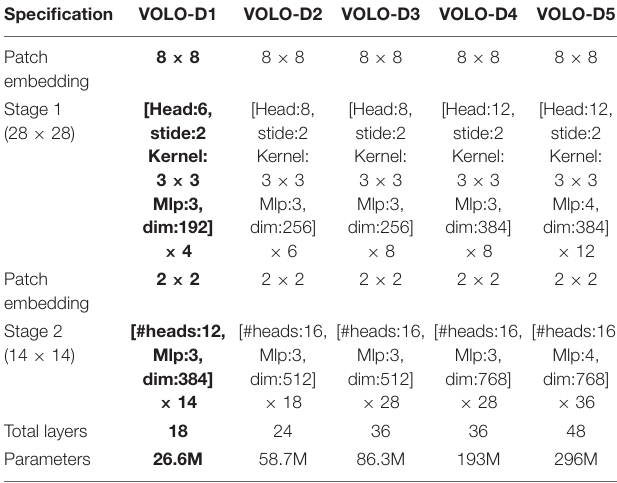
TABLE 1 | Architecture information of different variants of VOLO.